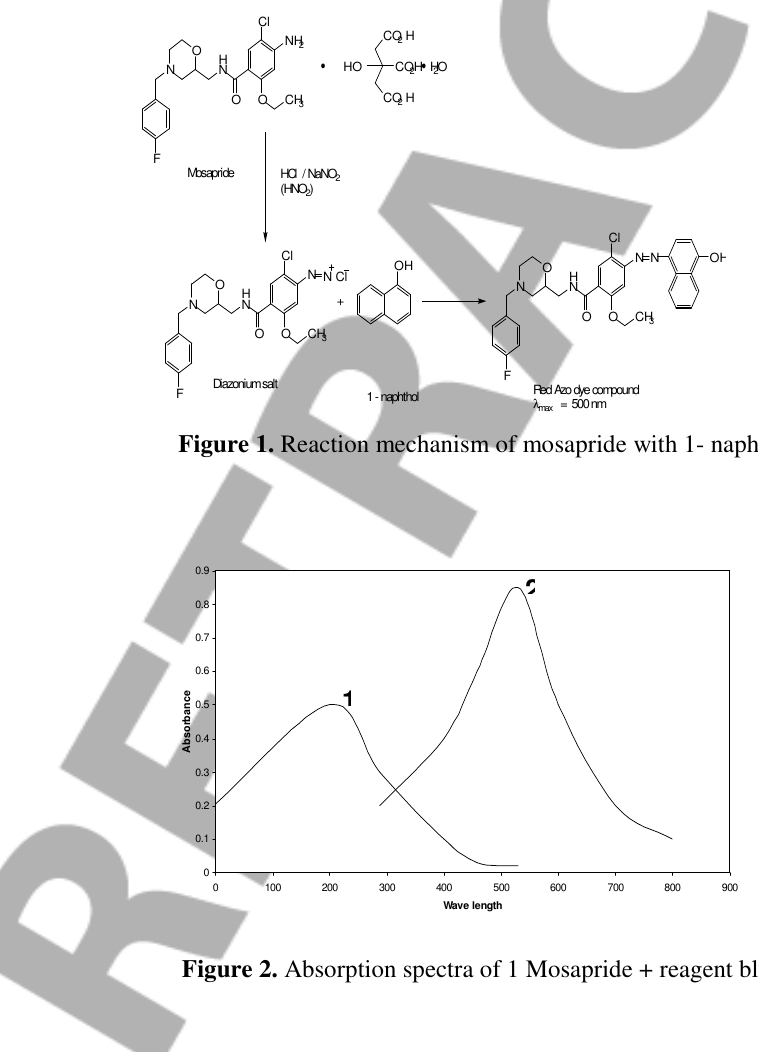
Figure 2. Absorption spectra of 1 Mosapride + reagent